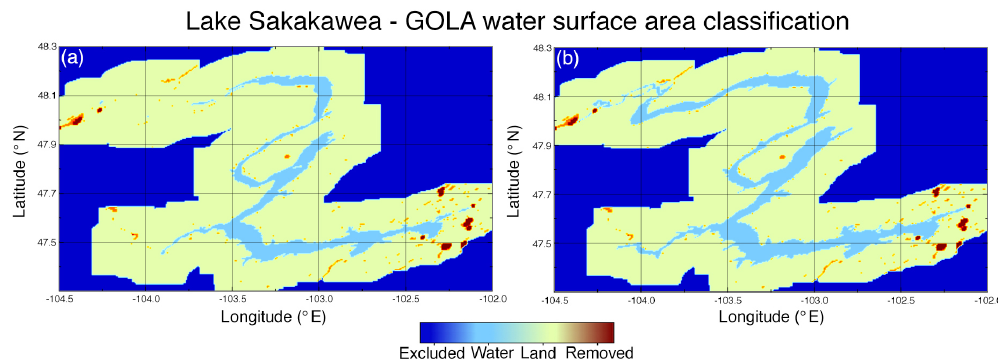
Figure 3. Examples of the GOLA WSA classification results for Lake Sakakawea: (a) dry scenario (1 November 2008); (b) wet scenario (25 April 2011). Differences in WSA estimates are noticeable in the northwestern and southwestern branches of the reservoir, the farthermost from the Garrison